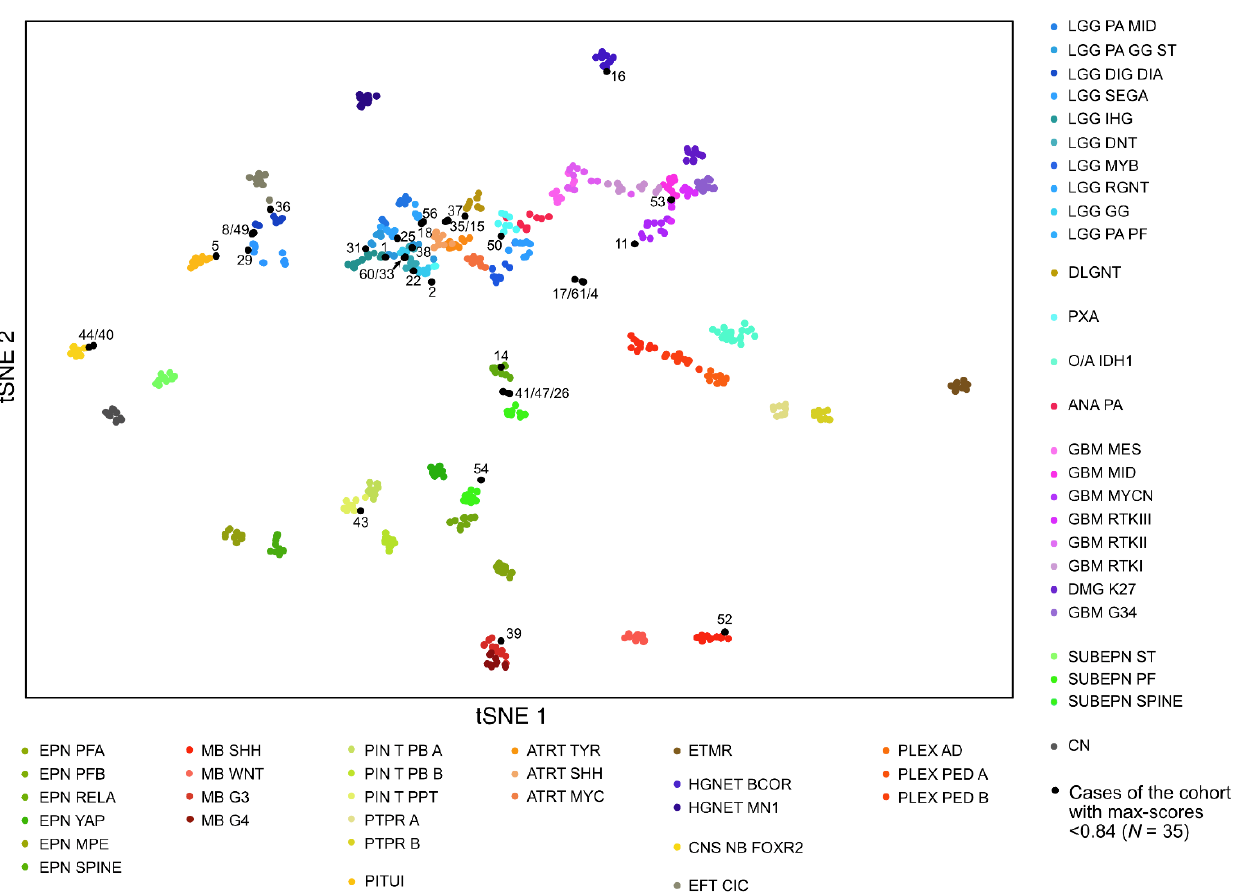
Figure 2. Methylation-based t-SNE (t-Distributed Stochastic Neighbor Embedding) distribution. The 35 tumors with a calibrated score <0.84 were compared with 675 reference samples from the German Cancer Research Center (DKFZ) cohort belonging to 53 methylation classes (colored dots). The 35 cases of this study are indicated as black dots and are shown by their ID number (see Table S1 for details on each case). Tumors that clustered within a reference group were considered belonging to the corresponding class if morpho-molecular data were consistent with the result.